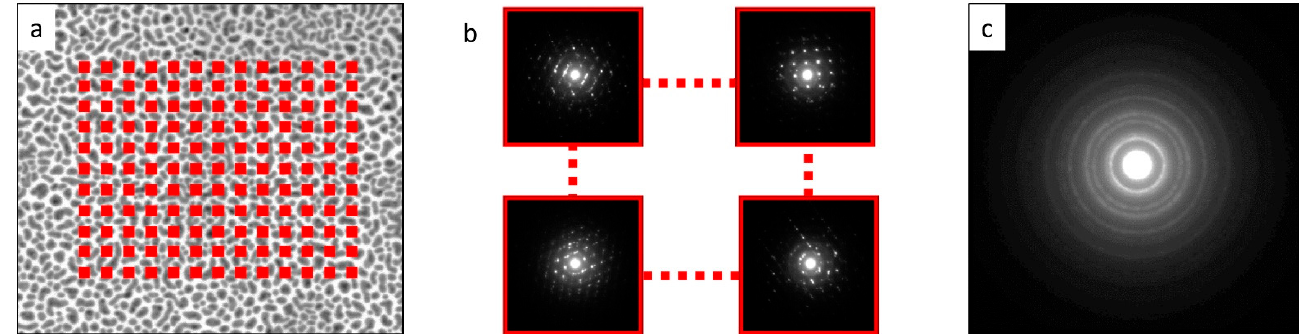
Figure 2. Principle of 4D-STEM/PNBD method: ( a ) Standard STEM/BF (bright-field) image of a sample with planed scanning matrix (represented schematically by red points). ( b ) Diffraction patterns captured from the individual locations (red points in ( a )). ( c ) Powder diffraction pattern obtained by summation of all individual diffraction patterns, showing diffraction rings that are typical of polycrystalline materials. All images come from the first testing sample (Au